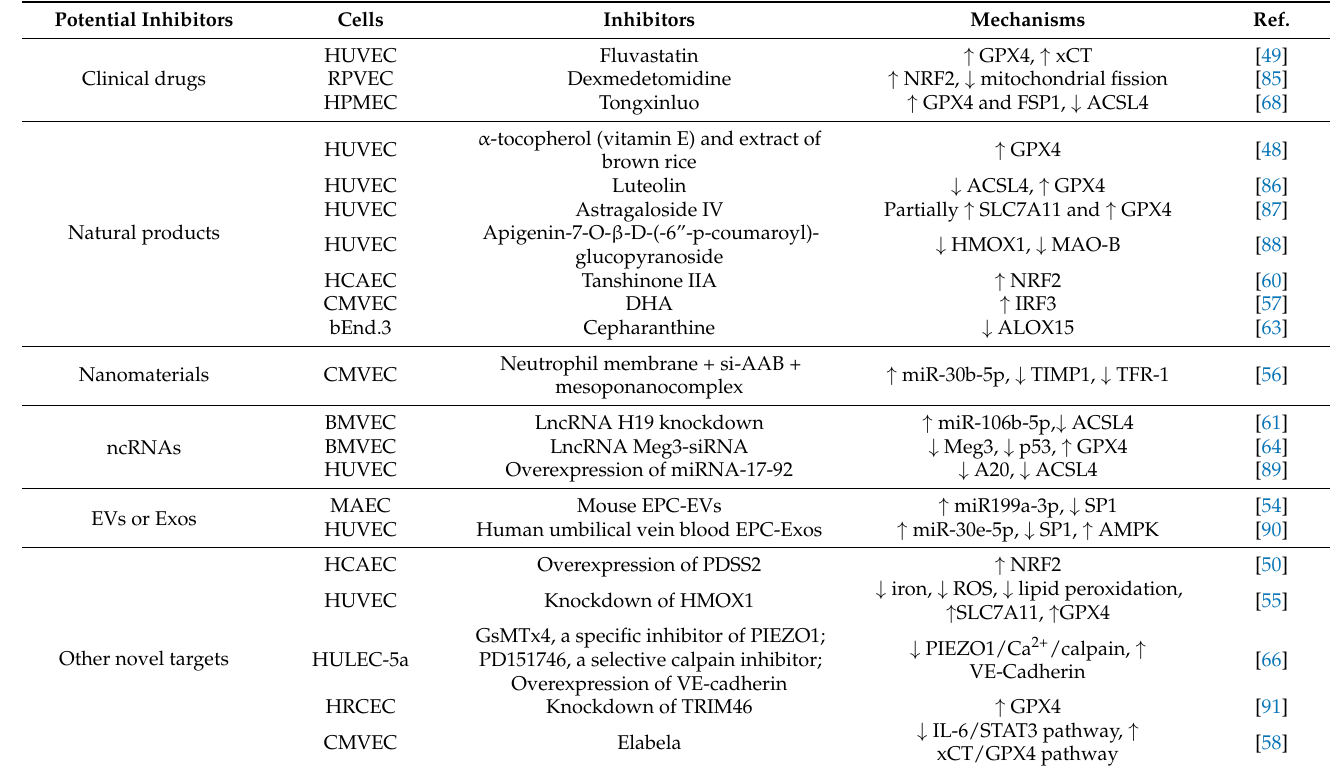
Table 3. Potential inhibitors of ferroptosis in